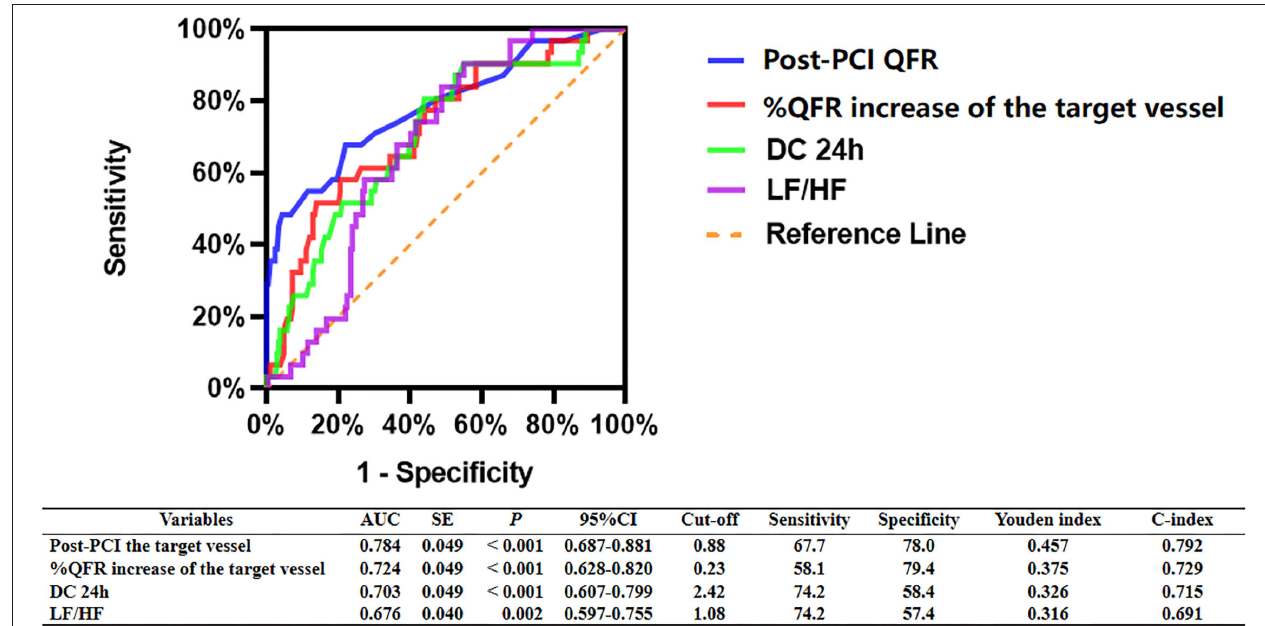
FIGURE 3 | ROC analysis comparing the predictive efficacies of related variables for the incidence of MACCEs during follow